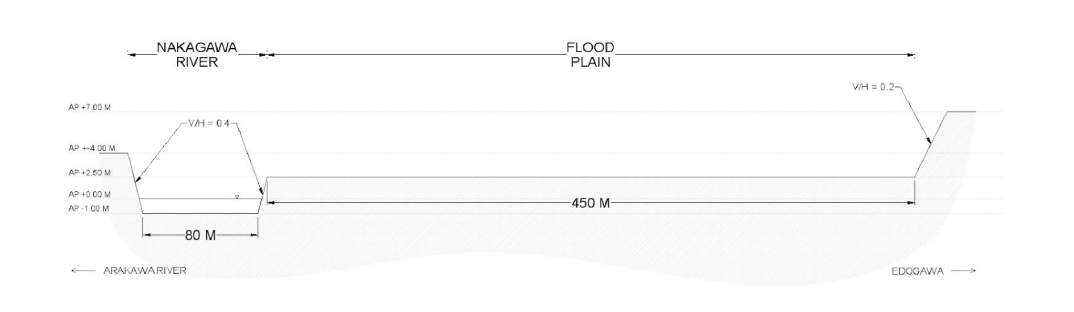
Figure 10. Simplified cross-section of Nakagawa River (source: Google Earth and Arakawa Karyu River Office